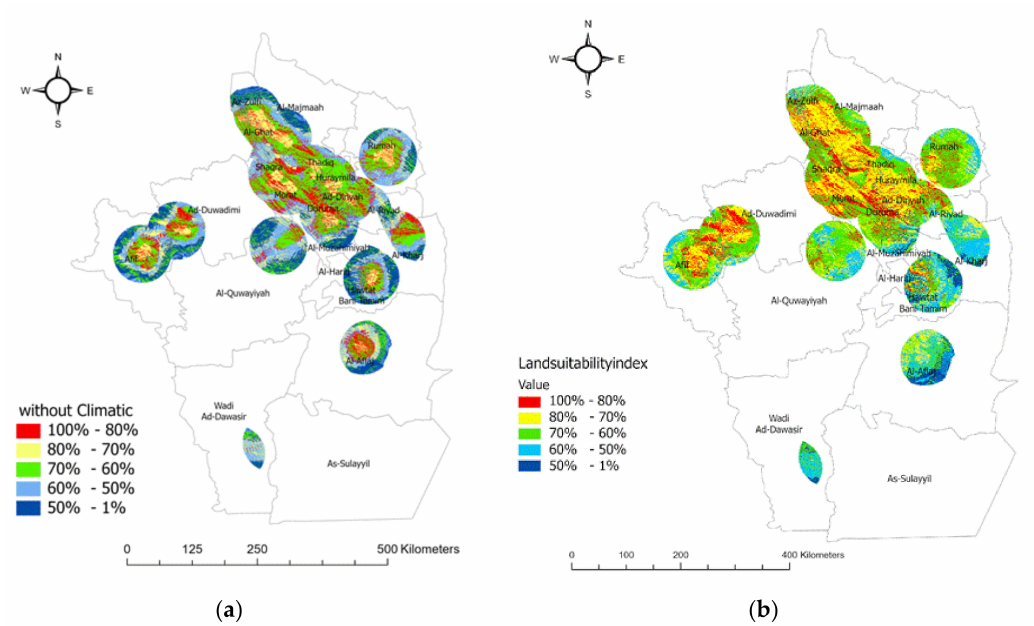
Figure 14. Sensitivity analysis without climatic factors ( a ); original ( b